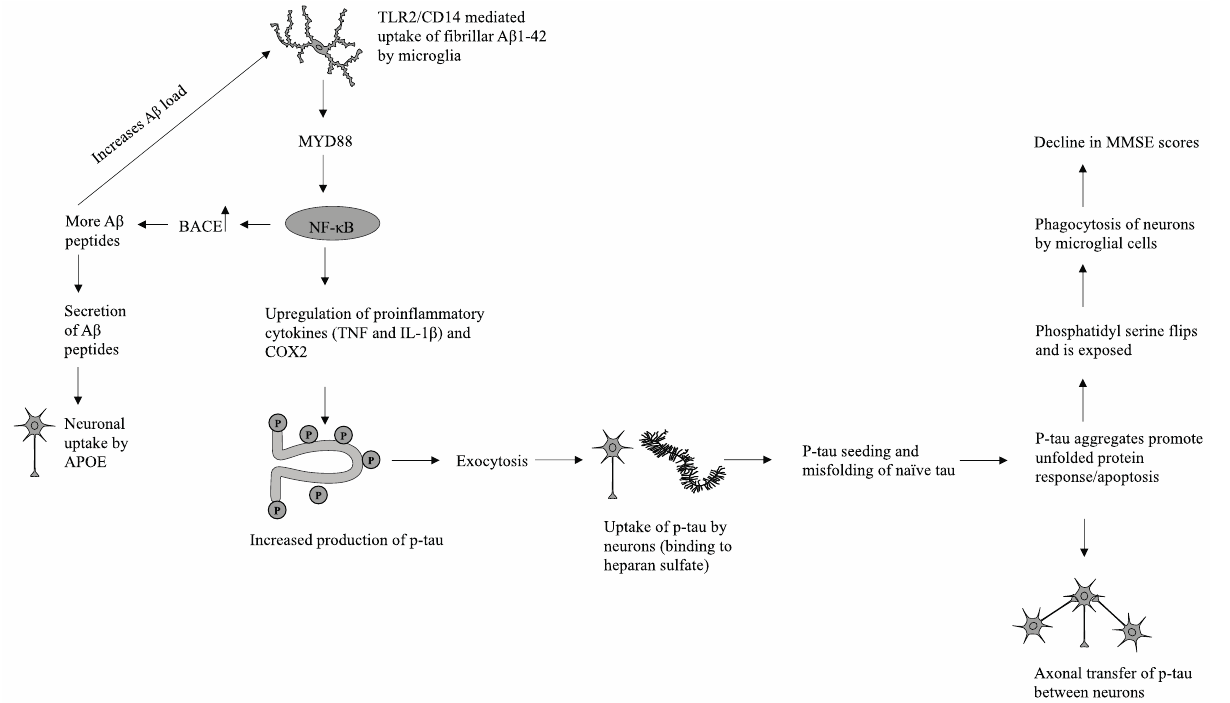
Figure 3. A possible mechanism that delineates the progression of p-tau aggregation and its subsequent deleterious effects on cognitive function as measured by MMSE.